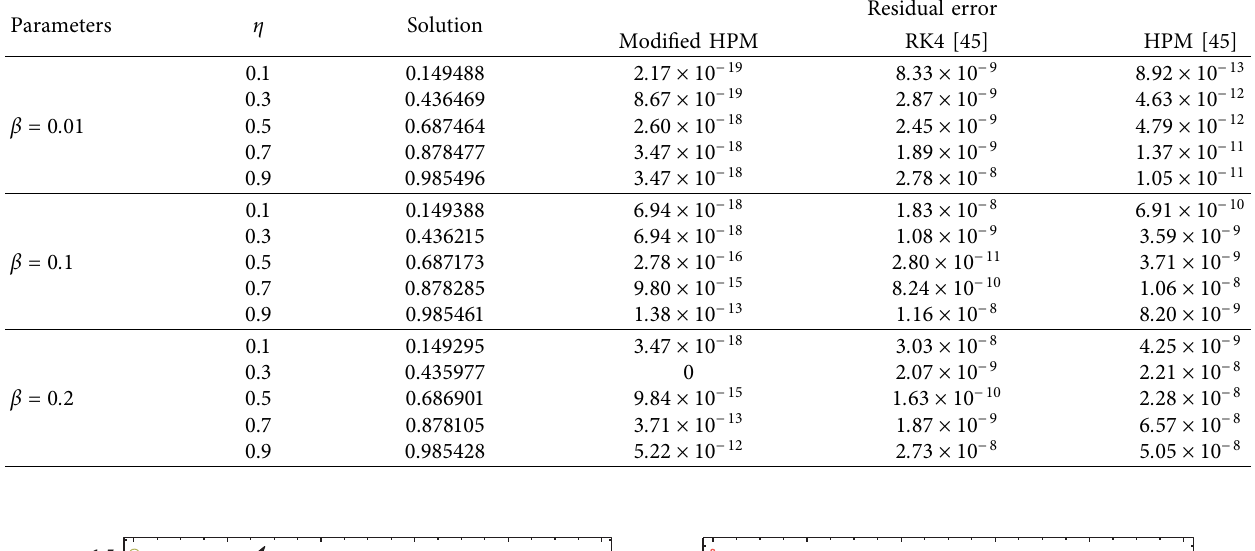
Table 2: Comparison of modifed HPM results with RK4 and HPM for diferent values of β when α � 1, M Parameters η Solution